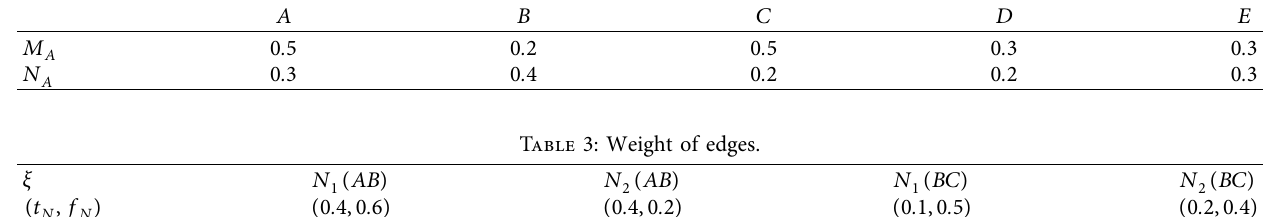
Table 2: Weight of vertices.